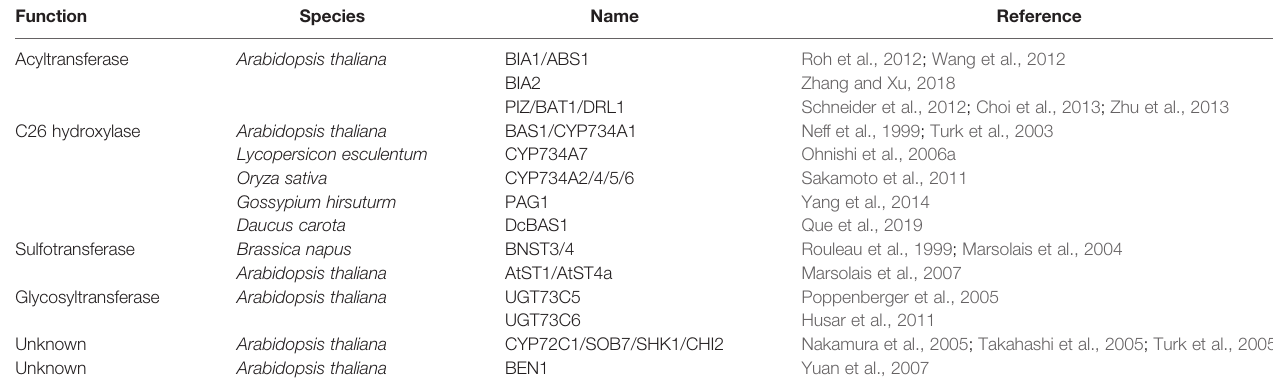
TABLE 3 | BR metabolism enzymes in different plant